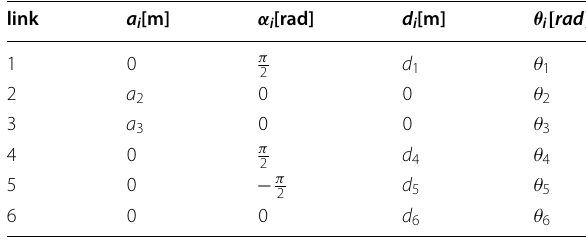
Table 1 Denavit-Hartenberg parameters for UR